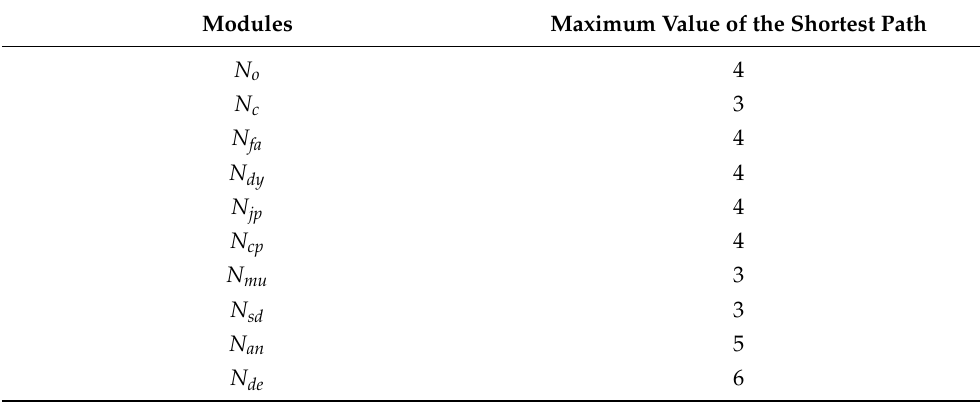
Table 2. Maximum value of the shortest path in each module. The maximum value of the shortest paths in most modules was 3 or 4, and only the value of the anxiety and depression gene modules reached 5 and 6, indicating that the gene connection in most modules was relatively